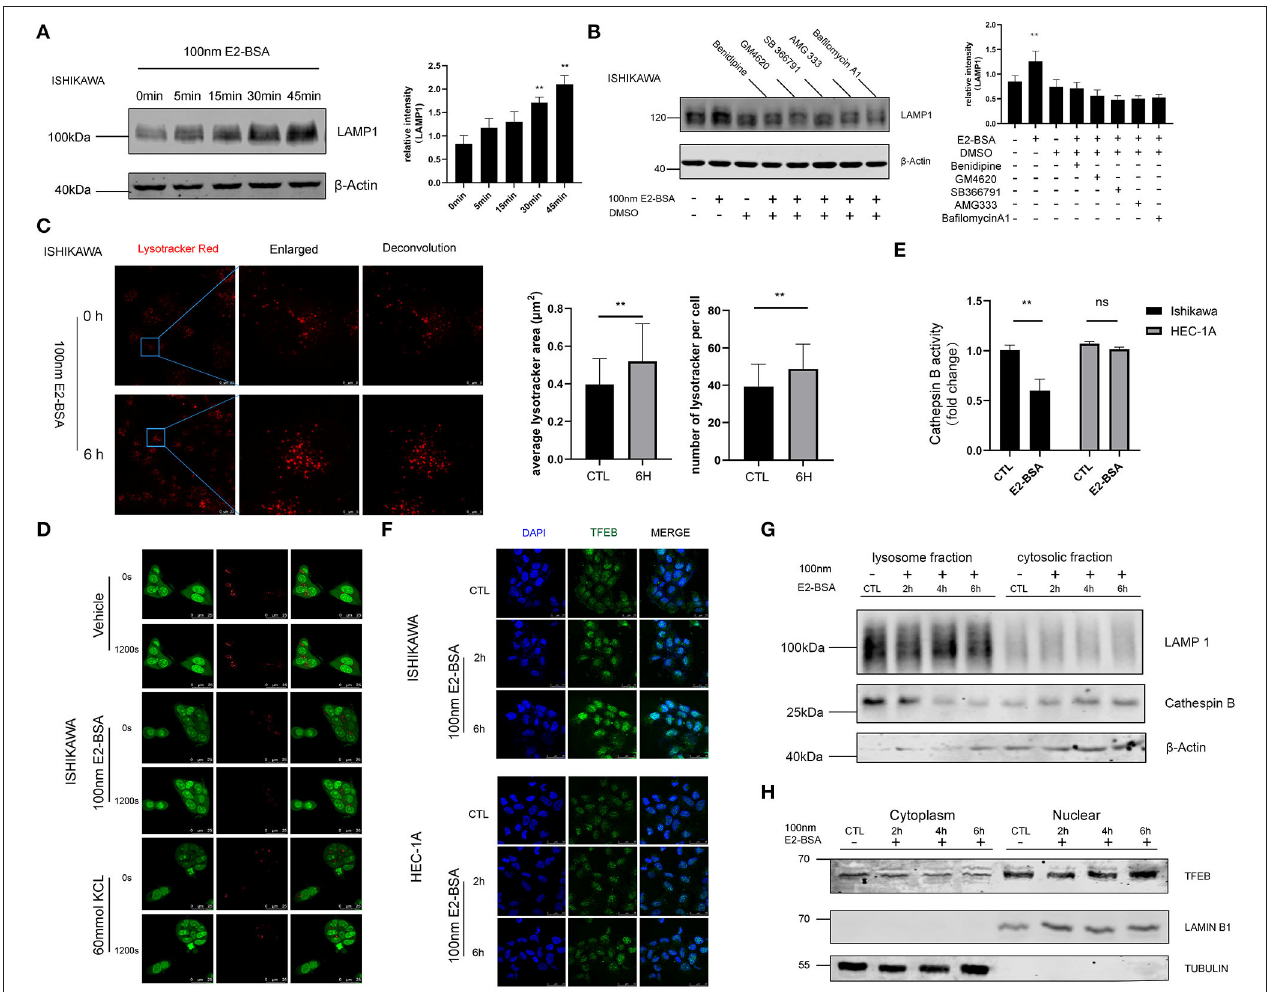
FIGURE 5 | The influence of estrogen-regulated calcium influx in Ishikawa and Hec-1A cell line lysosome. (A) An E2-BSA significantly promoted the LAMP1 expression in Ishikawa cells with rapid effect. (B) Inhibition of extracellular calcium influx reduced lysosomal response. (C) Effect of E2-BSA on lysosomes. The lysosomes were labeled by 5nM Lyso-Tracker Red (LTR) and examined confocal. Magnification 63 × . Scale bar 25 or 5 µ m. (D) Ishikawa cells stained with 5 µ g/ml acridine orange (AO) for 15min were then treated with E2-BSA and imaged under a confocal microscope (scale bar: 25 µ m). (E) E2-BSA treatment causes differential regulation in Ishikawa or HEC-1A cells. The activities of CTSB were measured by the fluorometric method using commercially available kits. All data are presented as the means ± SE. n = 3–4. (F,G) E2-BSA stimulated external calcium influx can activate the nuclear translocation of TFEB. (H) Effect of TFEB nuclear shift after E2-BSA treatment. All data are presented as the means ± SE. n = 50 for cell numbers and n = 3 for replicated. ns, non significant; ** p < 0.01 compared with the control